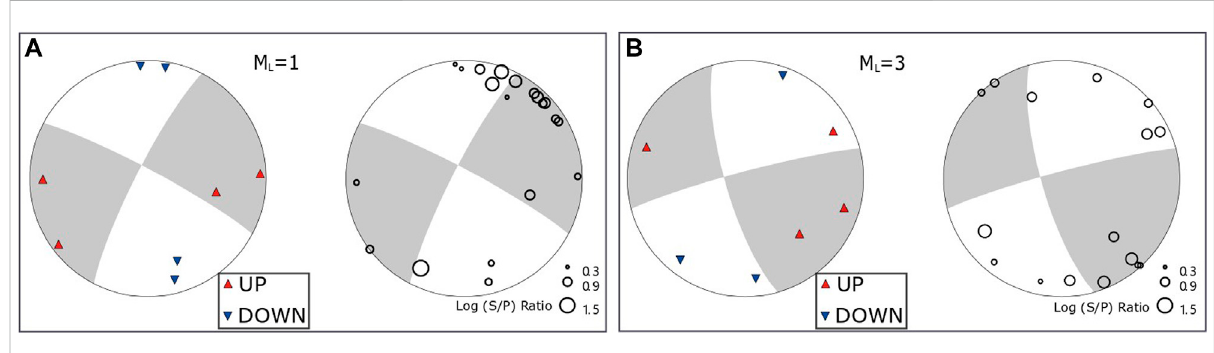
FIGURE 2 Two focal mechanism cases based on P-wave polarities and S/P ratios.